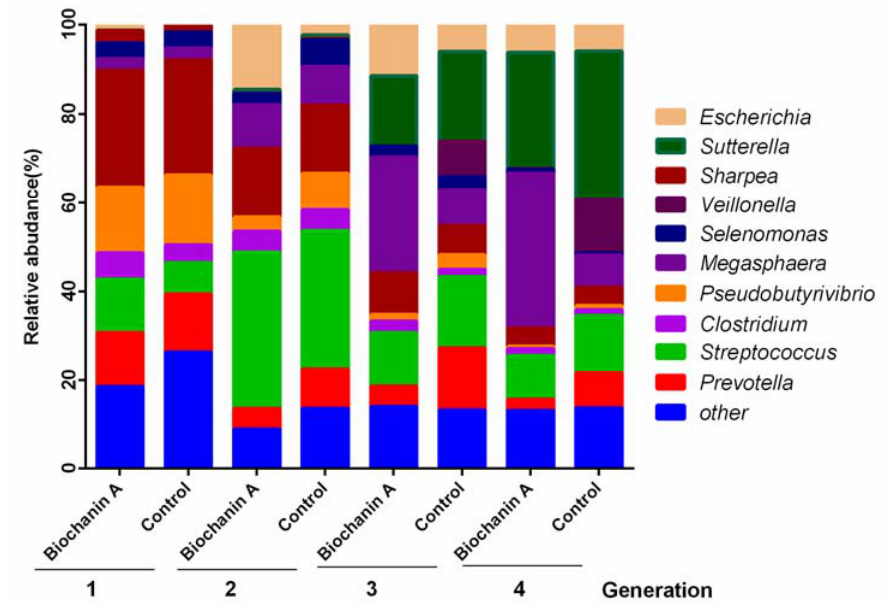
Figure 6. The e ff ect of biochanin A on the composition of the predominant bacterial genera in anaerobic Figure 6. The effect of biochanin A on the composition of the predominant bacterial genera in media of di ff erent culture generations. Treatments included controls (only DMSO) and anaerobic anaerobic media of different culture generations. Treatments included controls (only DMSO) and medium with exogenous addition of biochanin anaerobic medium with exogenous addition of biochanin A.